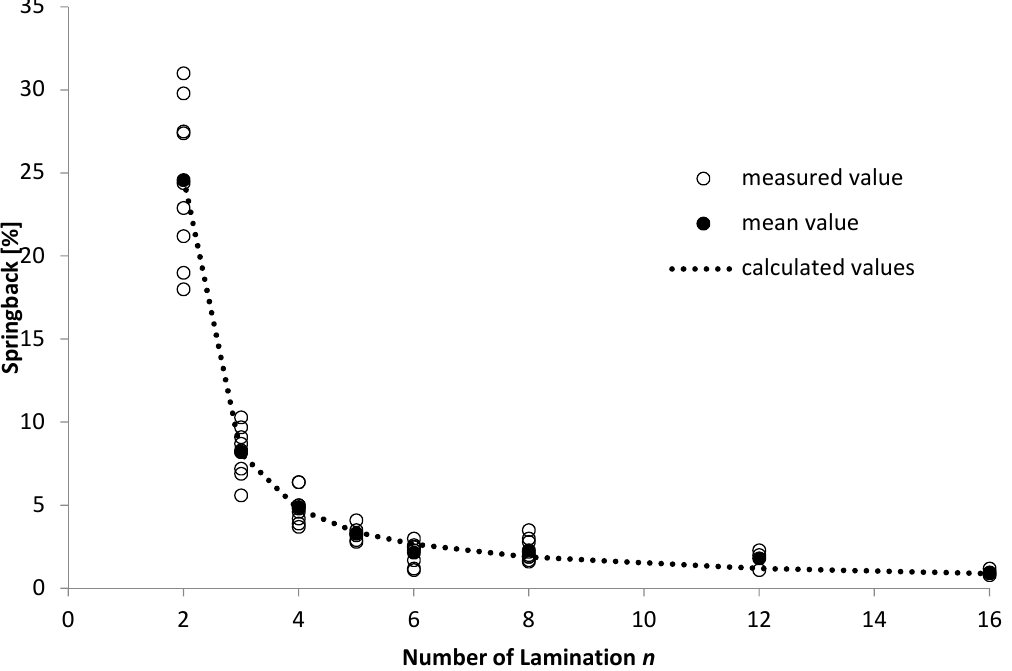
Figure 4. Trend curve from springback and number of laminations of all 57 samples. The black dot represents the arithmetic mean springback for each given value of n (circle).